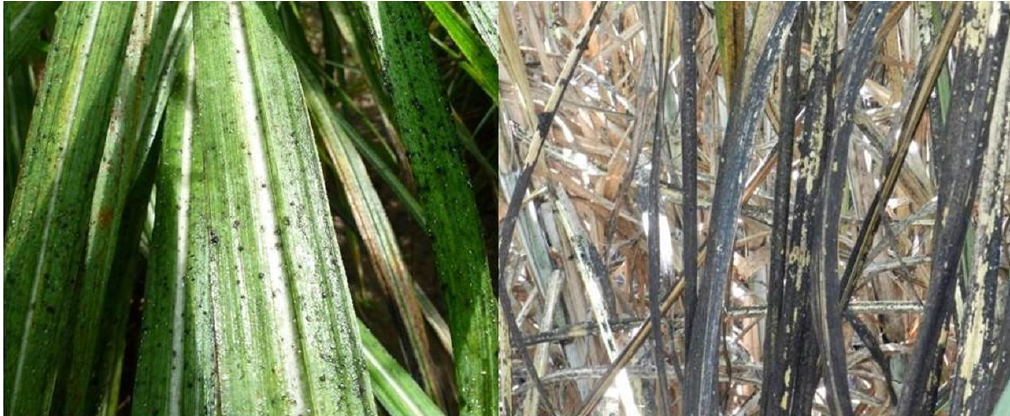
Figure 4. Sugarcane leaves covered in honeydew produced by S. saccharivora (left), and resulting sooty mold (right). Photos: © B.E. Wilson.